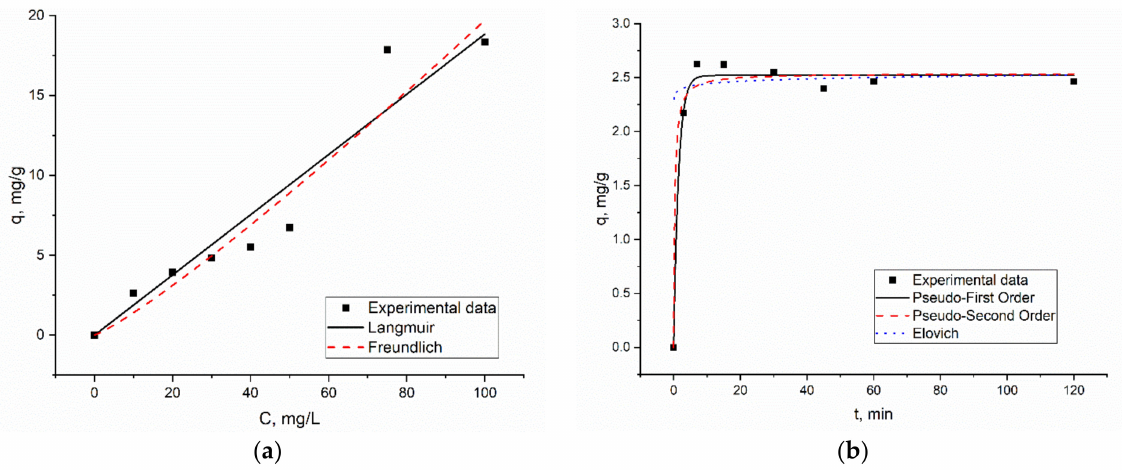
Figure 4. ( a ) equilibrium and ( b ) kinetics of Er(III) biosorption on A. platensis . Table 2. Constants of the kinetics and isotherm of Er(III) sorption on A. platensis . Isotherms Langmuir